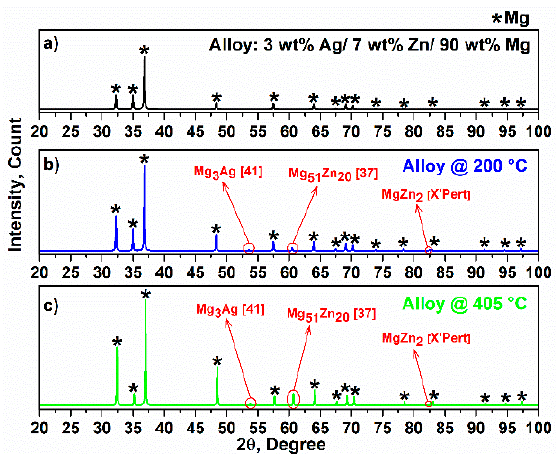
Figure 3. X-ray diffraction of ( a ) alloy and sintered alloy at ( b ) 200 °C and ( c ) 405 °C.